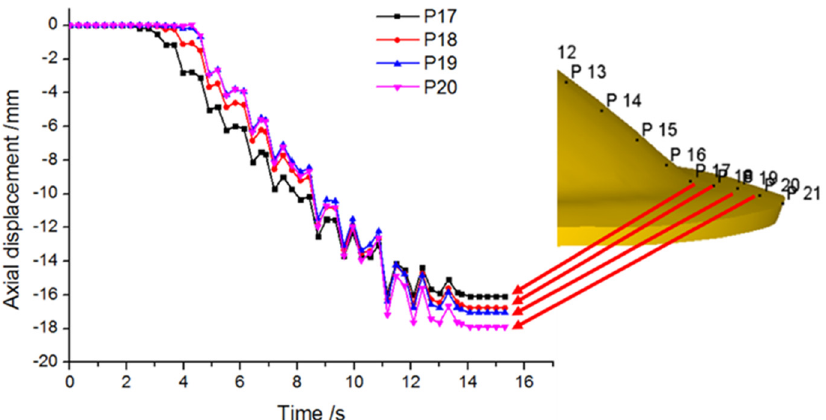
Figure 6. Axial displacement of the sampling point in Zone 4 and 5.